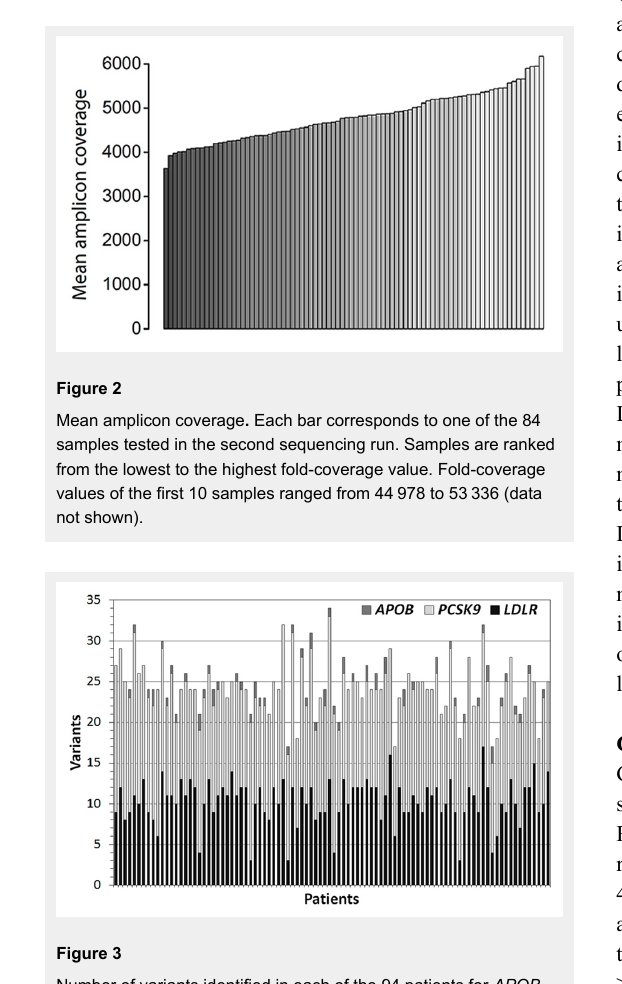
Number of variants identified in each of the 94 patients for APOB , LDLR , and PCSK9 . Each bar corresponds to a single sample.